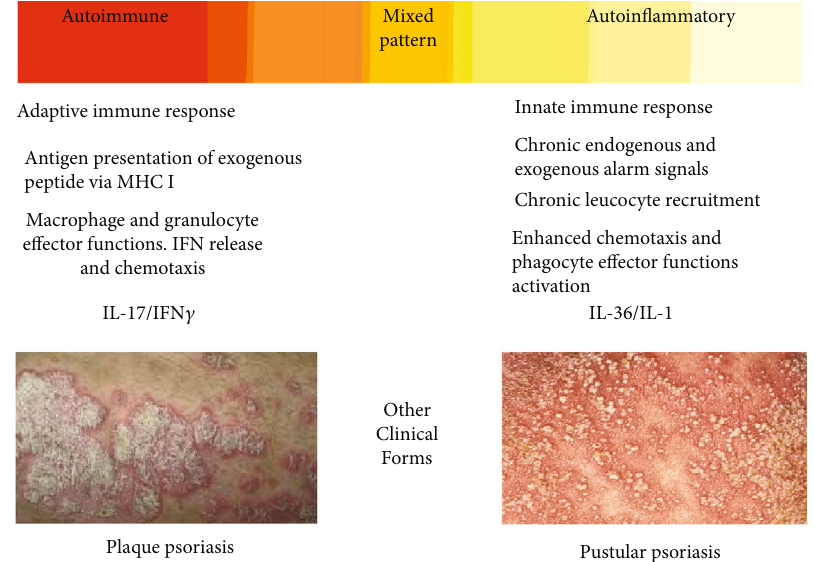
Figure 2: Autoimmune vs. autoin fl ammatory responses in psoriasis. Complicate interactions between the innate and the adaptive immune systems characterize the pathophysiology of psoriasis. Once settled, the relative contribution of in fl ammatory and regulatory mediators of adaptive and innate immunity determines the clinical manifestation towards chronic stable vs. highly in fl ammatory and/or pustular psoriasis. Plaque psoriasis (psoriasis vulgaris) and generalized pustular psoriasis (psoriasis pustulosa) represent autoimmune (IL-17A/IFN- γ secretion pro fi le) and autoin fl ammatory (IL-36/IL-1 secretion pro fi le) response patterns,